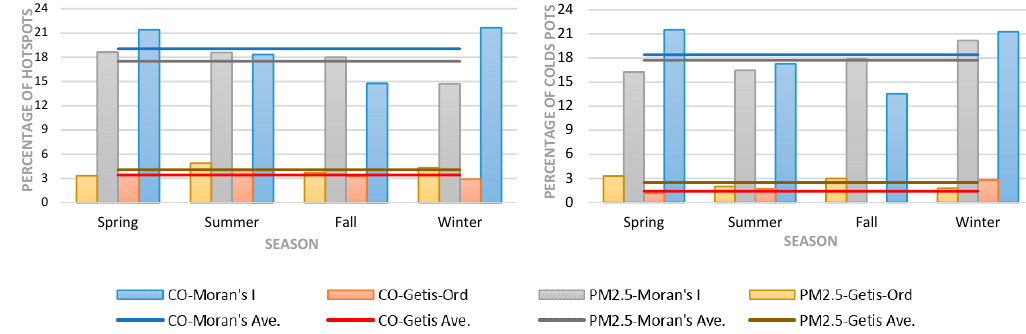
Figure 5. The percentage of hotspots ( left ) and cold spots ( right ) of carbon monoxide (CO) and fine particulate matter (PM 2.5 ) throughout the study area.